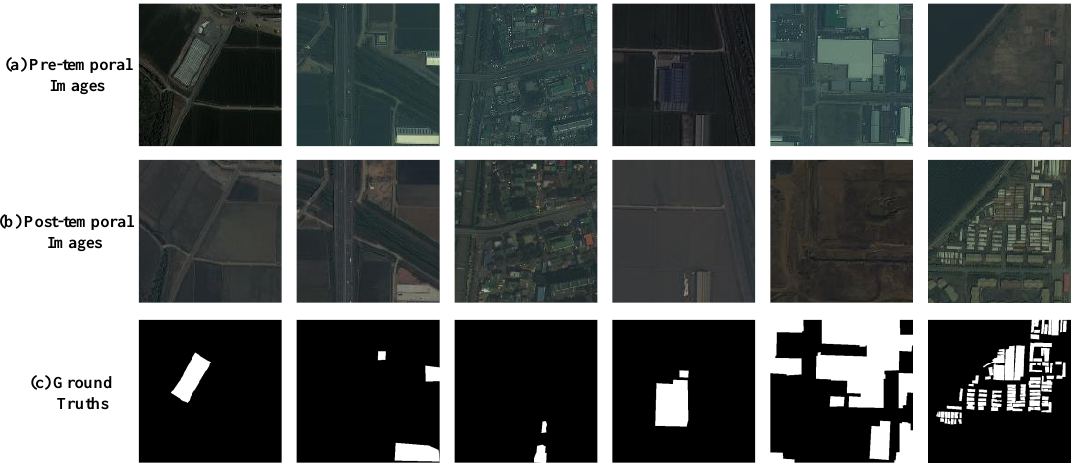
Figure 6. A demonstration of six scenarios from the S2Looking-CD dataset.